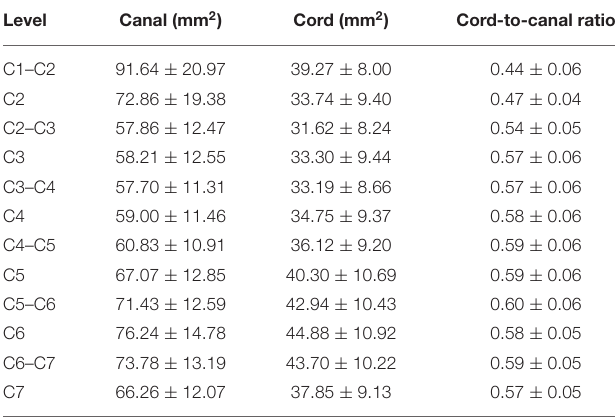
TABLE 5 | Cross-sectional area (CSA) of the spinal canal and cord measured on transverse images and ratio of the CSA of the spinal cord to the canal.